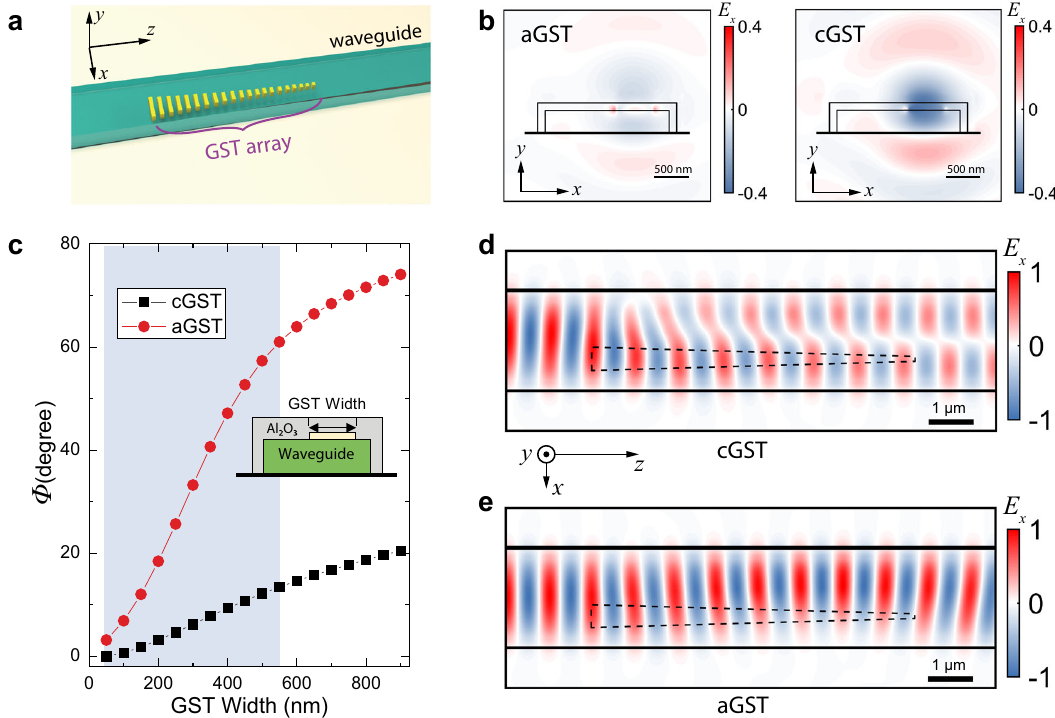
Fig. 1 Design of the phase-gradient metasurface mode converter. a 3D illustration of the devices. b FDTD simulation of the scattered electric fi eld by one nano-antenna when the GST is in aGST (left panel) and cGST (right panel) phases, respectively, showing the distinctive difference. c . The phase of the scattered mode as a function of the GST nano-antenna width for cGST and aGST phases. The shaded region indicates the range of antenna widths that are used in the phase gradient metasurface. Inset: cross-sectional view of the structure. d , e FDTD simulation results showing effective mode conversion from the TE 0 mode to the TE 1 mode when the GST is in crystalline phase ( d ), but only a small perturbation when the GST is in amorphous phase ( e